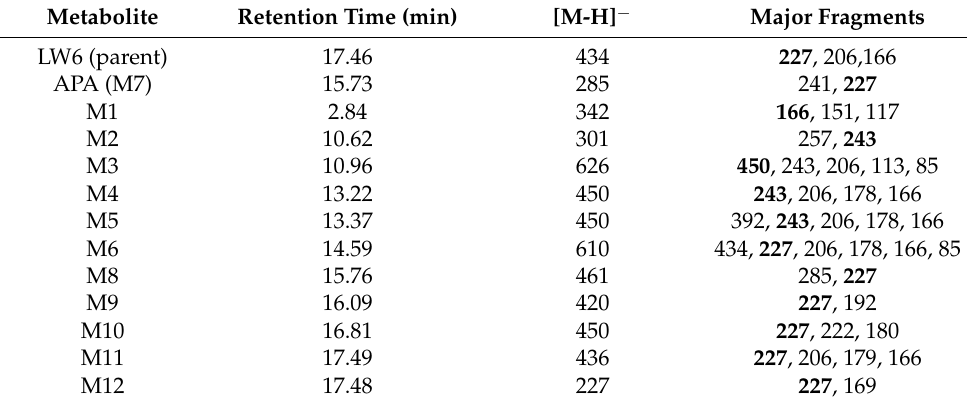
Table 1. Major MS/MS fragments of LW6 and its